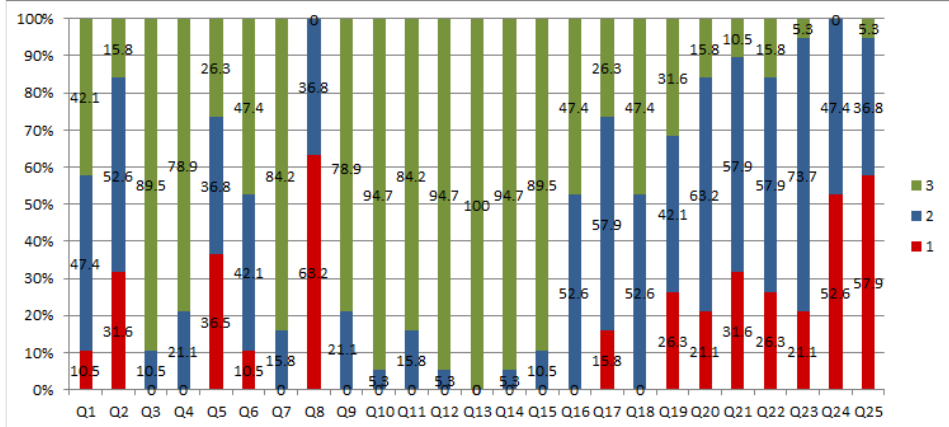
Figure 9. Evaluation of students’ learning